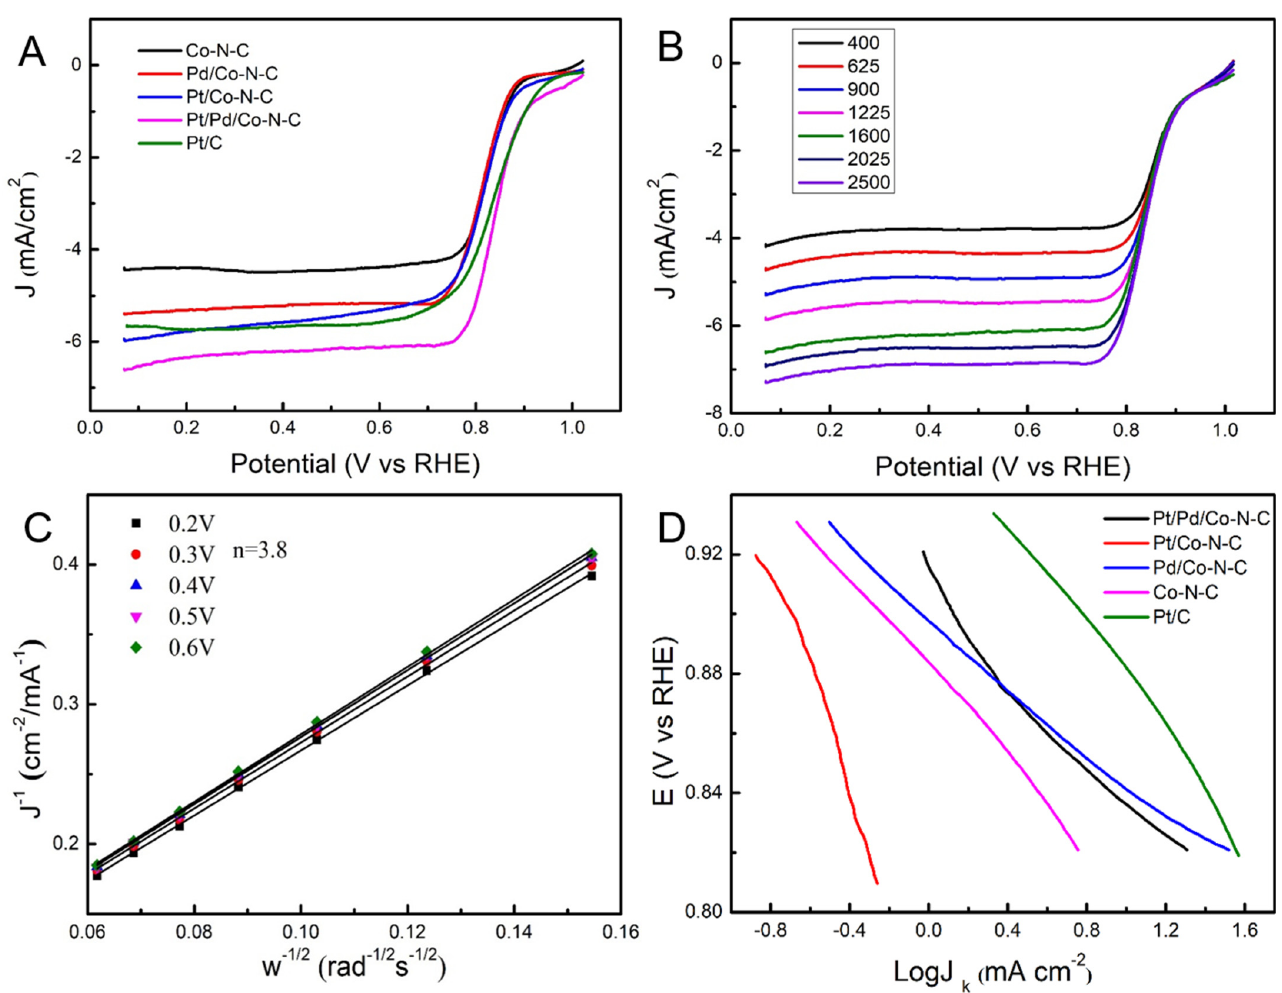
Figure 4. The LSV curve of several catalysts in 0.1M KOH saturated with oxygen ( A ); The LSV curve of Pt/Pd/Co-N-C at different speeds in 0.1 M KOH saturated with oxygen ( B ); K–L curve and electron transfer number of Pt/Pd/Co-N-C ( C ); Tafel slopes of several materials ( D ).